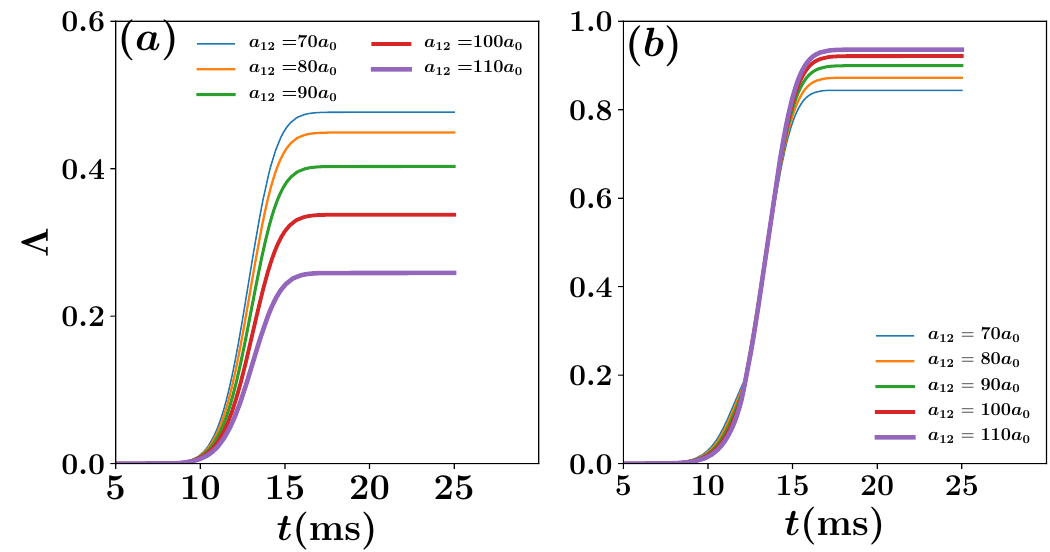
Figure 4. (Color online) Illustrates the number of atoms transferred to the condensate Ψ 2 as a function of intercomponent scattering length a 12 and the light–matter interaction parameter V max . The colorbar shows the fraction of atoms in condensate Ψ 2 with respect to the total number of atoms N = 10 4 in the system at the end of the transfer process. The population transfer from Ψ 1 to Ψ 2 is carried-out using LG(pump)-G(stokes) pulse sequence. The system is confined in a harmonic trapping potential with frequency ω = 2 π × 30.832 Hz and the intraspecies scattering lengths are a 11 = 100.04 a 0 and a 22 = 95.44 a 0 .